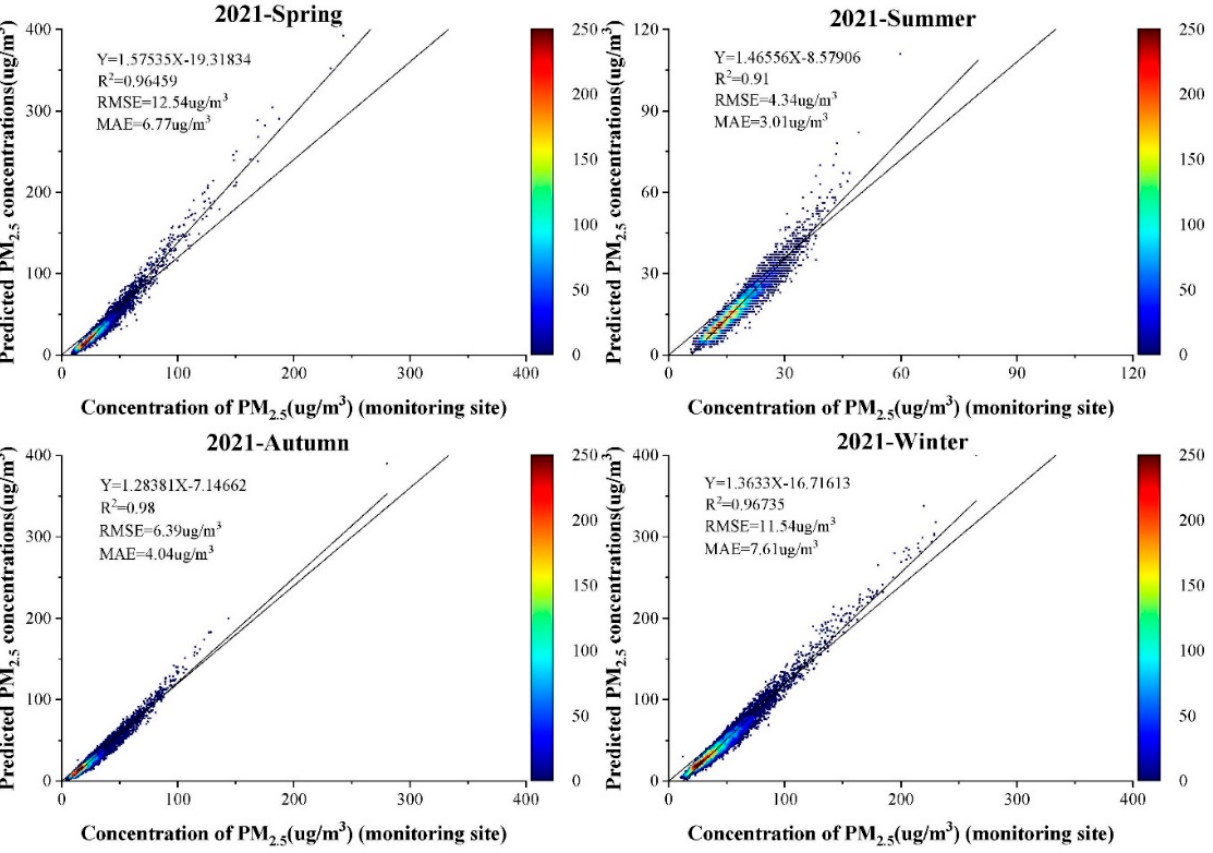
Figure 5. Scatter density map based on LUR ‐ GBM model for all seasons in 2021.